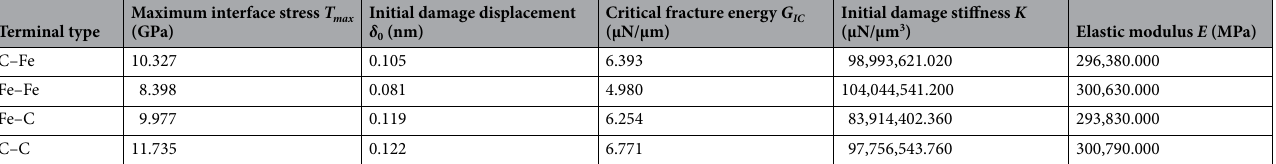
Table 9. MD simulation results.